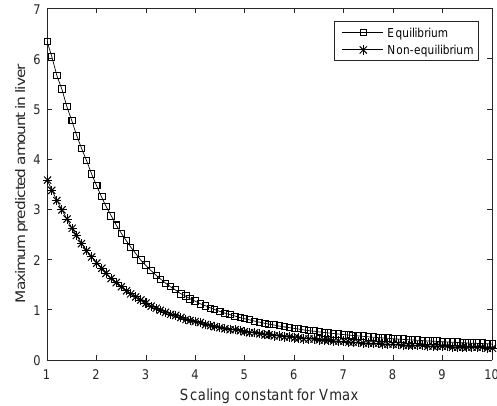
Fig. 4. Maximum model output for the amount of xylene in the liver for various V xyl maxc values.